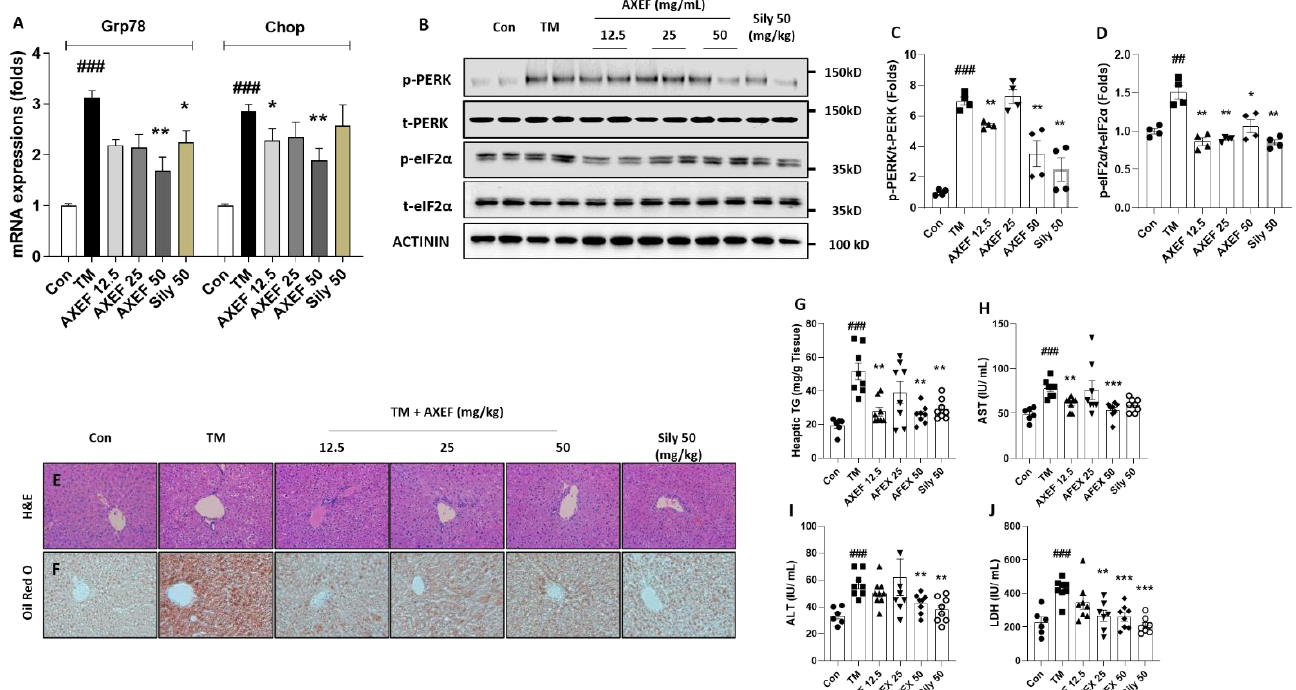
Figure 1. Effects of AXEF on the ER stress and NASH by TM injection in a mice model. ( A ) Hepatic mRNA expression levels of Hspa5 and Ddit3. ( B ) Western blot analysis of ER stress molecules of p-PERK, t-PERK, p-eIF2 α , and t-eIF2 α in the hepatic protein lysates. ( C ) and ( D ) Protein intensity of ER stress related proteins for p-PERK, t-PERK, p-eIF2 α , and t-eIF2 α . ( E ) Hepatic H&E staining and ( F ) Oil Red O staining. ( G ) Hepatic tissue levels of TG and liver enzymes in the serum levels including ( H ) AST, ( I ) ALT, and ( J ) LDH, respectively. Data are expressed as the mean ± SD (n = 6–8 for each group for PCR and hepatic TG, AST, ALT, and LDH; n = 4 for Western blot analysis, respectively). ## p < 0.01; ### p < 0.001 for the Con vs. TM, * p < 0.05; ** p < 0.01; *** p < 0.001 for TM vs. AXEF or Sily 50. Images were captured using light microscopy at 100 or 200× magnification.